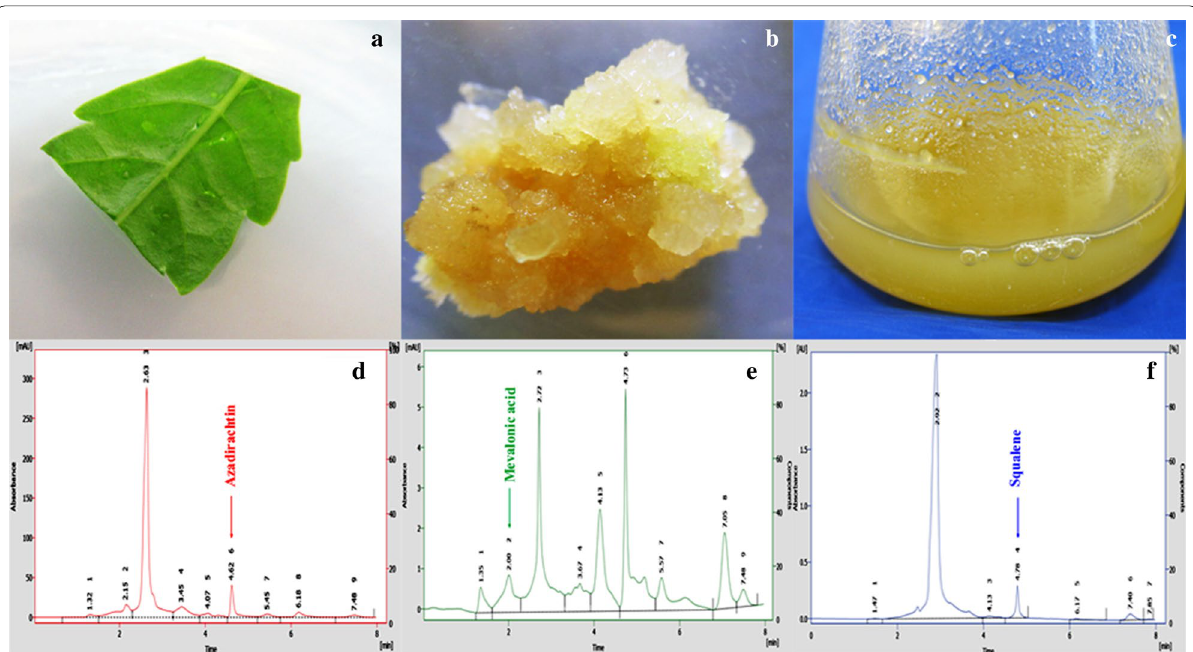
Fig. 1 The leaf explant ( a ), callus production ( b ), established cell suspension culture of A. indica ( c ), and HPLC chromatograms of azadirachtin ( d ), mevalonic acid ( e ), and squalene ( f